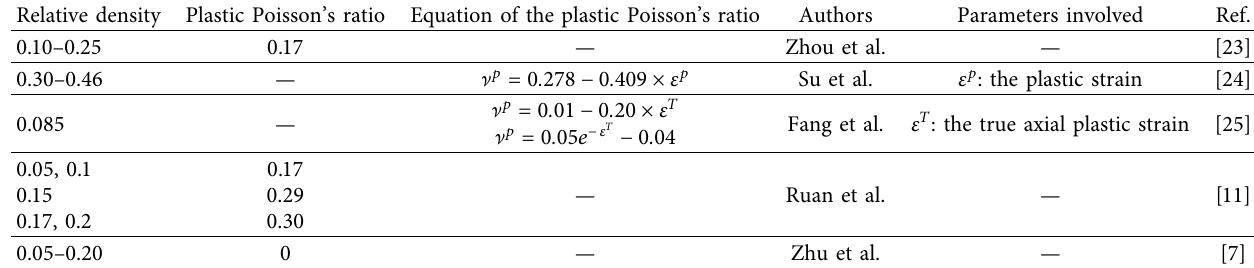
Table 2: The investigation for the plastic Poisson’s ratio of aluminum foam with different relative densities.